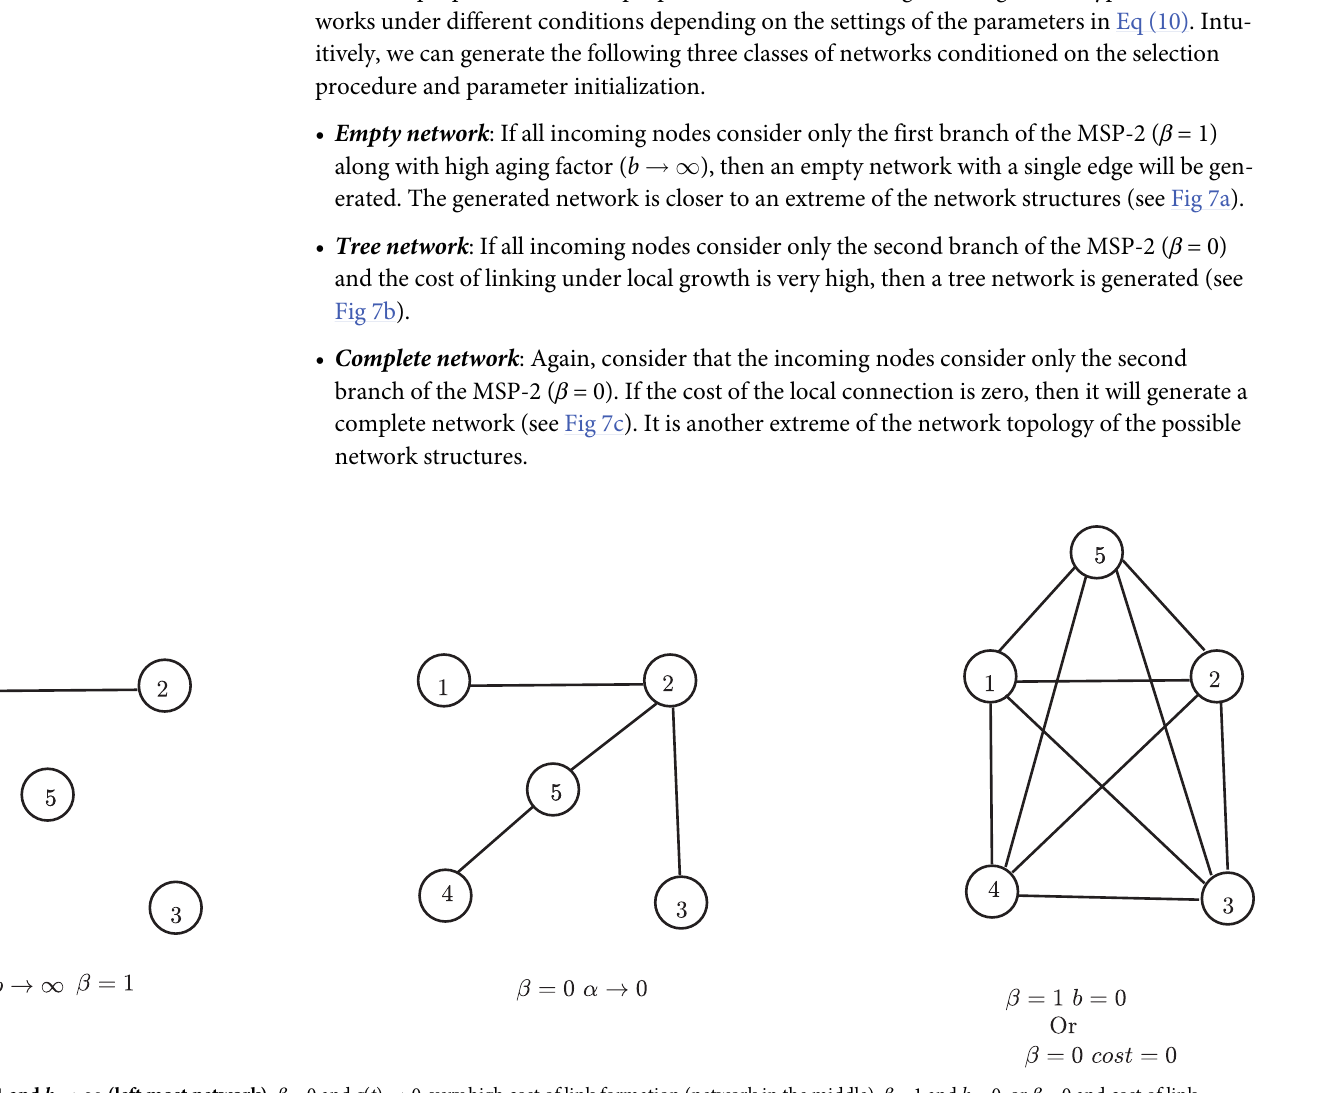
PLOS ONE | https://doi.org/10.1371/journal.pone.0224383 December12,